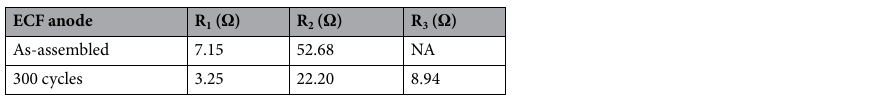
Table 2. Comparison of fitted impedance parameters of the ECF electrode (thickness: 13.7 mm) before cycling and after 300 cycles.